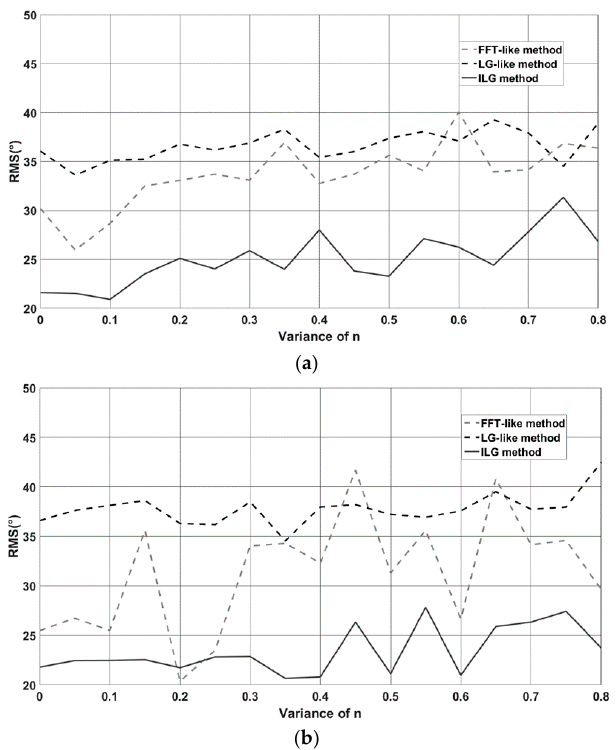
Figure 14. RMS differences between the retrieved results of each method and the interpolating wind directions when the multiplicative noise exists with different variance: ( a ) ECMWF and ( b ) CCMP.